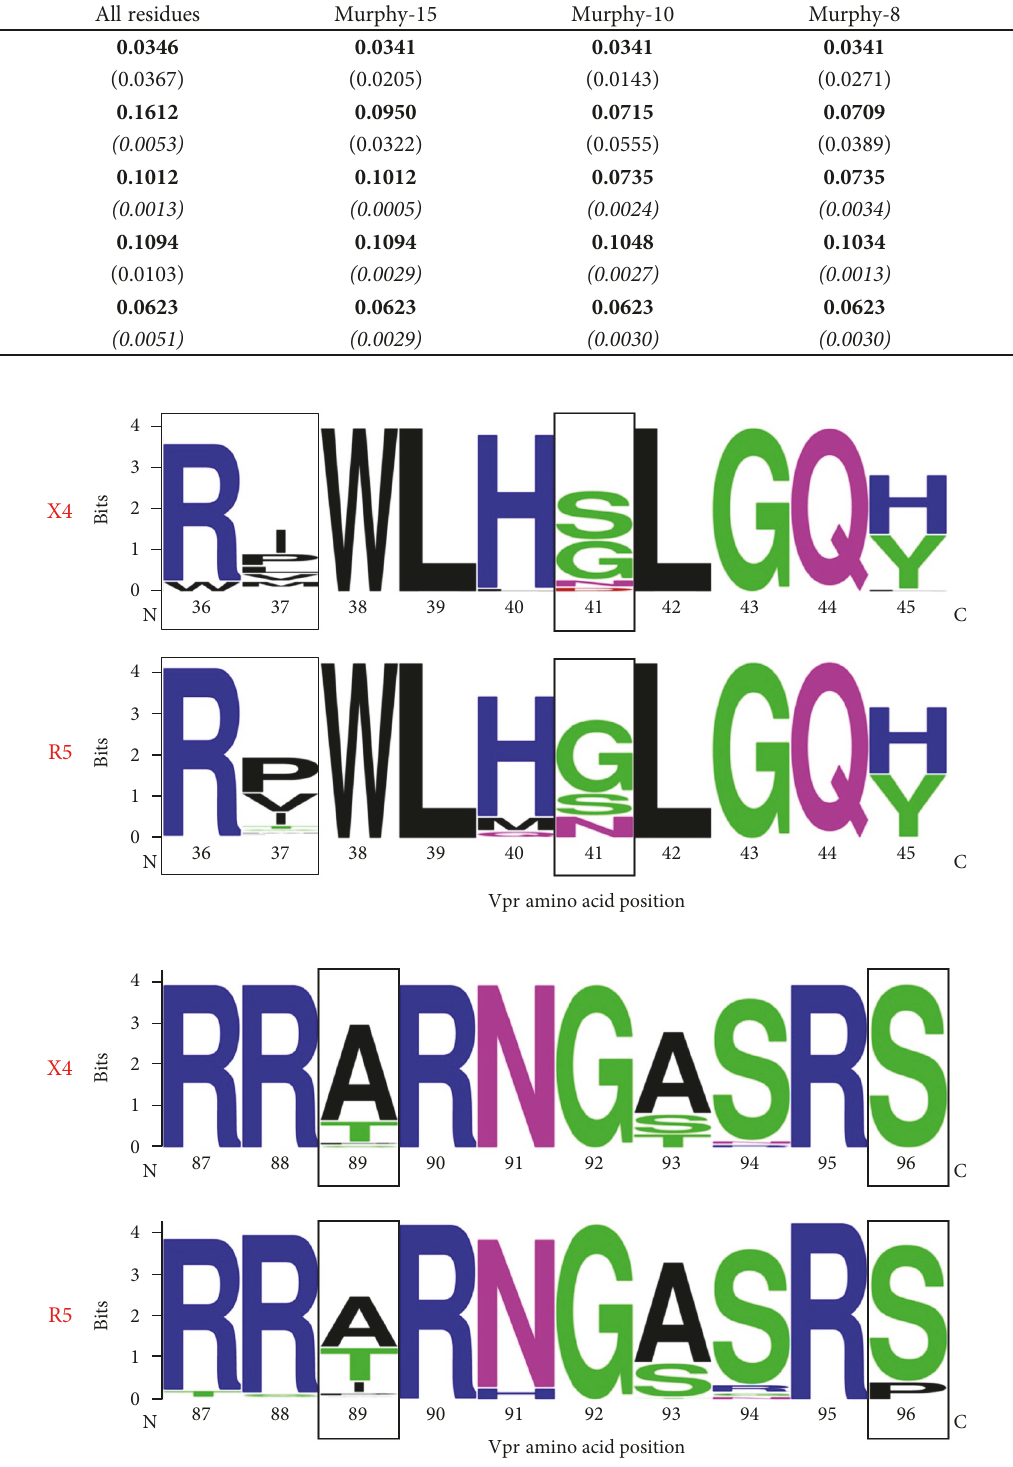
Figure 4: Sequence logos for Vpr regions 36 – 45 and 87 – 96. Both regions within the Vpr amino acid sequence included several peaks in amino acid diversity across multiple alphabets. They also contained all positions (36, 37, 41, 89, and 96) found to be statistically divergent using Jensen-Shannon divergence (boxed sequence